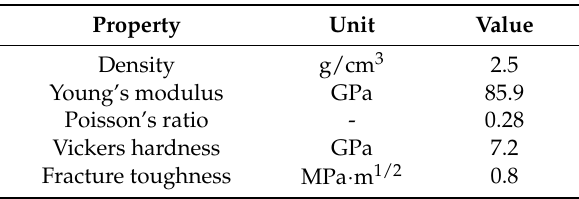
Table 1. Properties of K9 glass